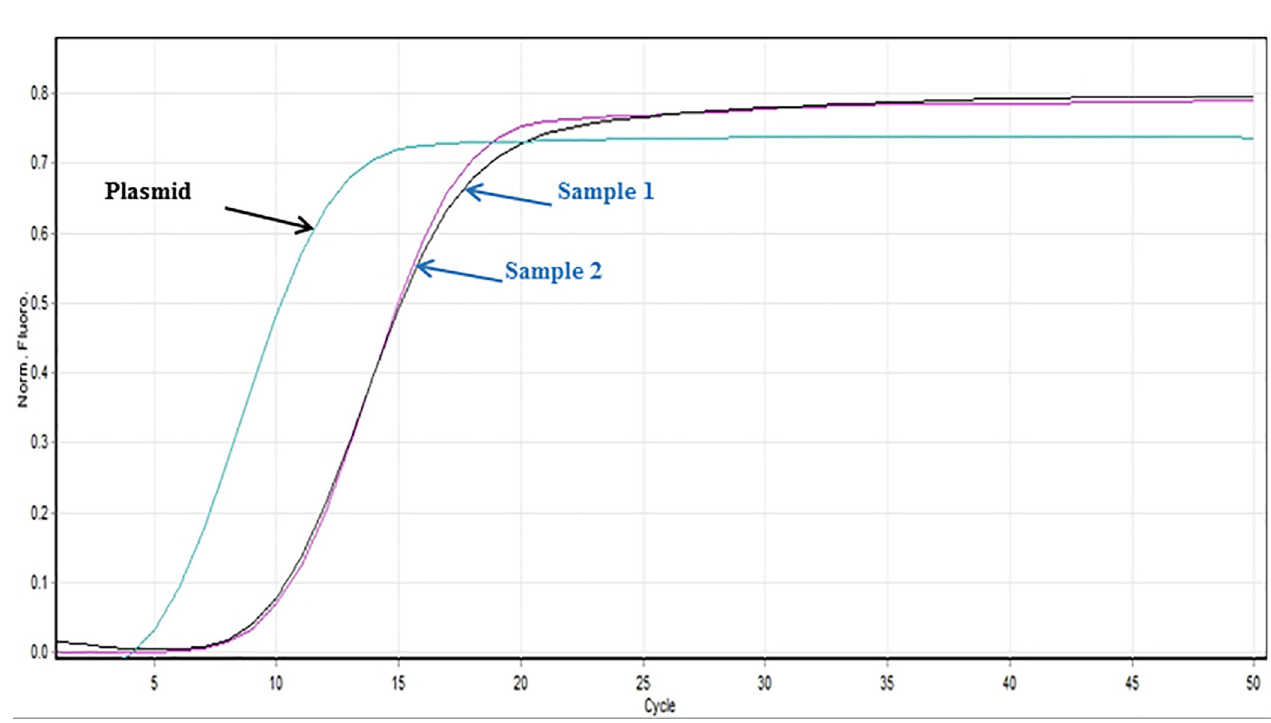
Fig 9. RT-qLAMP specificity assays with GspSSD2.0 DNA polymerase. (A) RT-qLAMP specificity using RNA of nine reference control viruses, healthy rose tissue, RRV symptomatic rose tissue (Sample1, 2), and RRV-P3 plasmid.